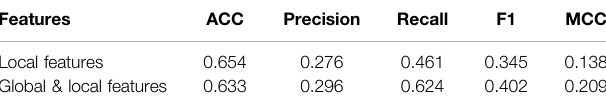
TABLE 2 | Predictive performance when using local features and using combined local and global features with the DeepPPISP-XGB model. Features